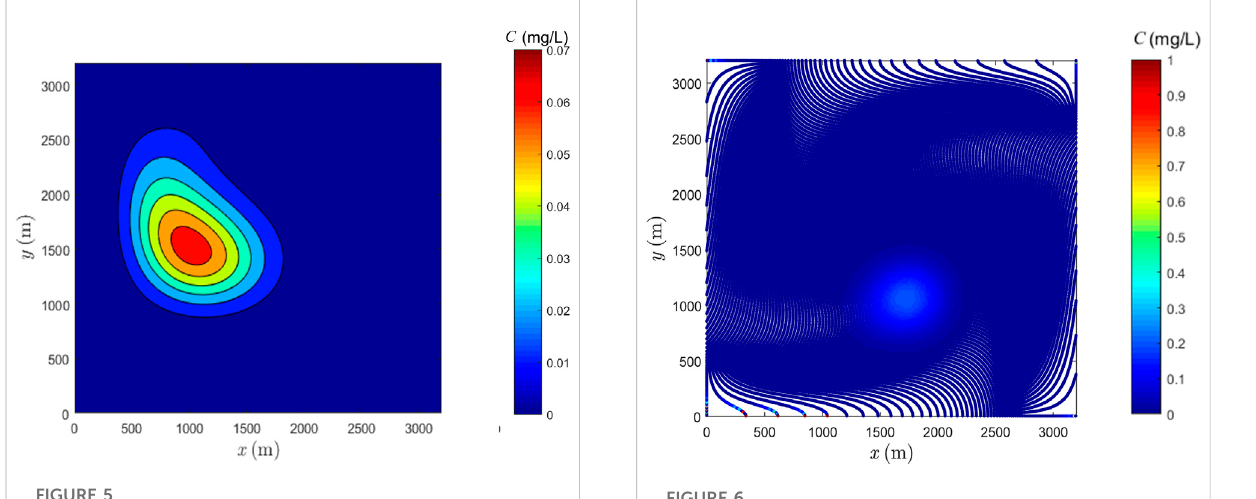
FIGURE 5 Reference solution obtained by MTVDLF-Superbee with grid number 400 by 400 and dt = 0.005 s.